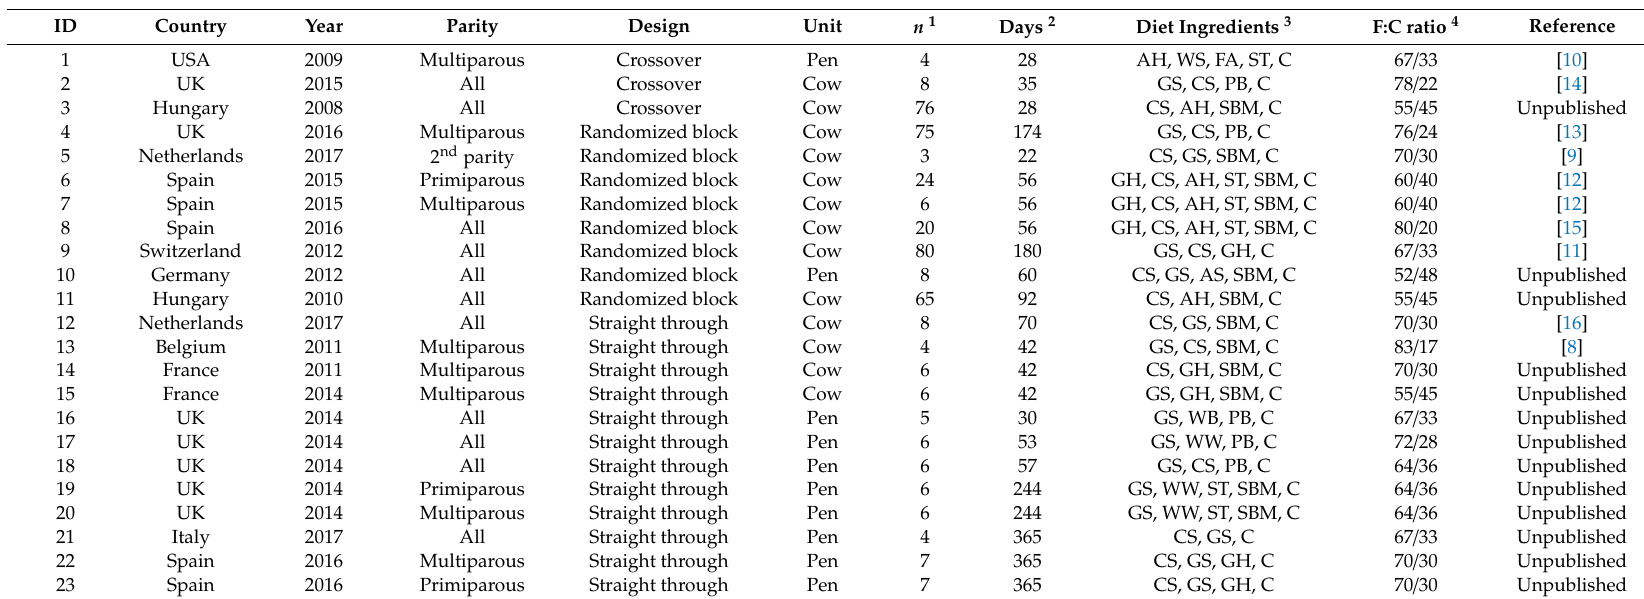
Table 1. Summary of the studies included in the